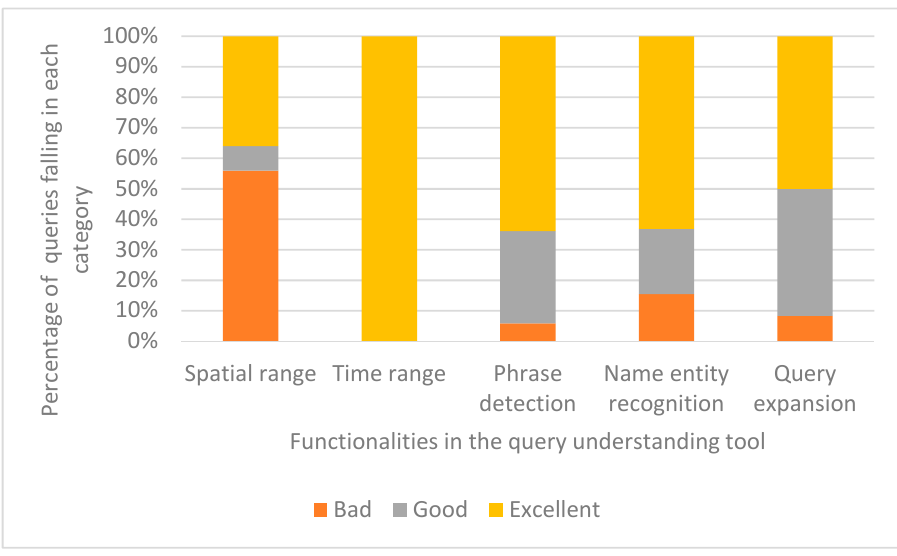
Figure 10. Evaluation of valid query understanding results of 169 synthetic queries.